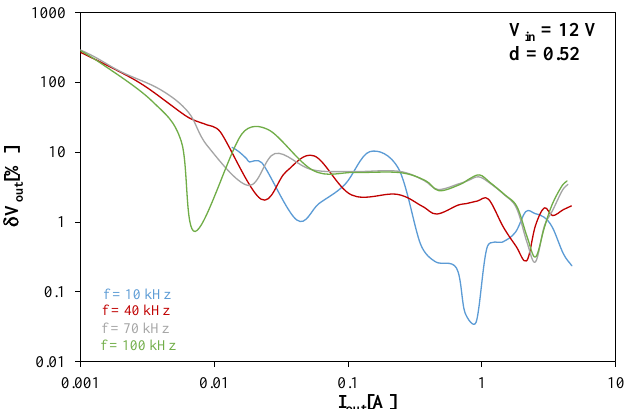
Figure 8. Computed values of the relative error in determining the output voltage as the function of the converter output current.